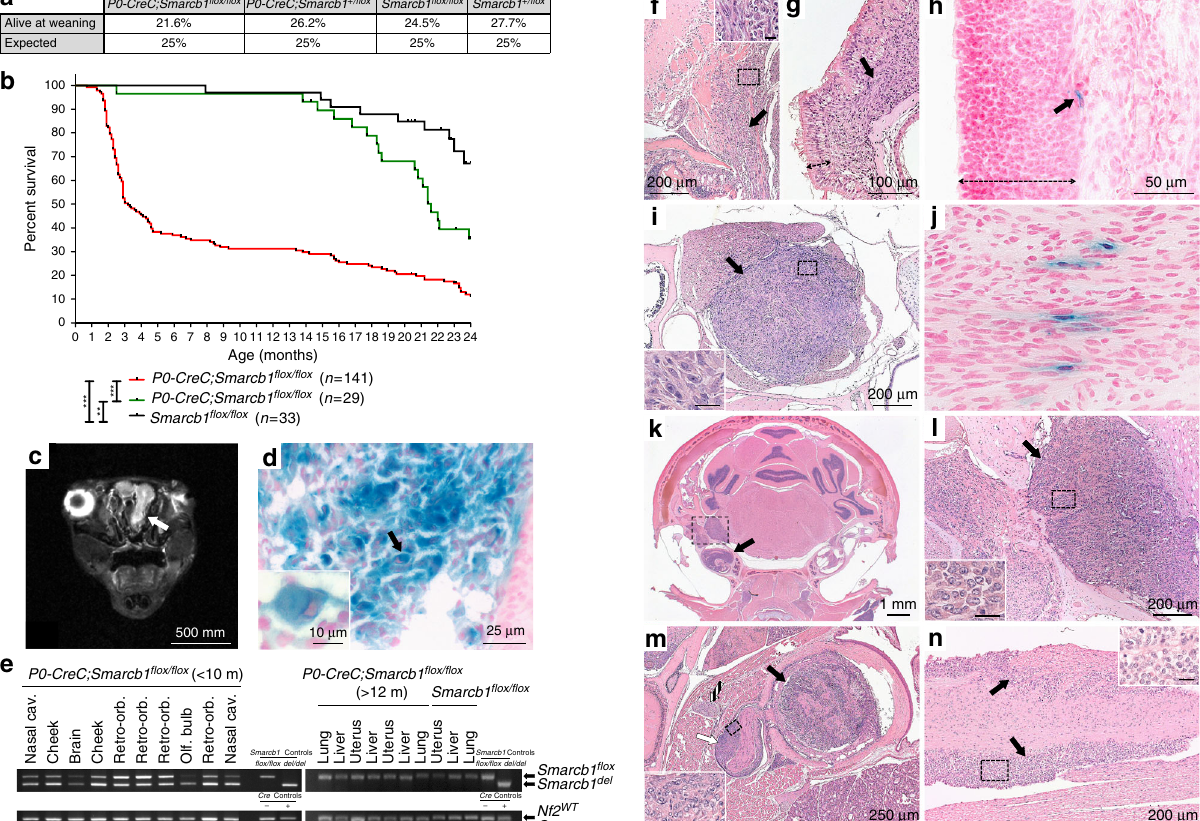
Fig. 1 P0-CreC;Smarcb1 fl ox/ fl ox mice develop RTs in NC-derived tissues. a Genotype distribution of mice at 3 weeks of age ( n = 282) born from crossings of P0-CreC;Smarcb1 fl ox/ + and Smarcb1 fl ox/ fl ox mice. b Kaplan – Meier curve representing the percent survival of P0-CreC;Smarcb1 fl ox/ fl ox ( n = 141, median survival = 3.2 months), P0-CreC;Smarcb1 fl ox/ + ( n = 29, median survival = 21.6 months) and Smarcb1 fl ox/ fl ox ( n = 33, median survival > 24 months) mice versus age in months. c T2-weighted MR image identifying a tumor mass in the nasal cavities of a P0-CreC;Smarcb1 fl ox/ fl ox mouse ( arrow ). d X-gal staining of a tumor from P0-CreC;Smarcb1 fl ox/ fl ox ; ACZL mice demonstrating activation of the beta-galactosidase reporter gene ACZL ( blue staining) thus attesting for Smarcb1 deletion throughout the tumor and in rhabdoid cells ( arrow and inset ). e Smarcb1 del allele is detected in all the tumors from young P0-CreC; Smarcb1 fl ox/ fl ox mice ( < 10 months of age). Long-term P0-CreC;Smarcb1 fl ox/ fl ox survivor mice (Supplementary Fig. 2c) develop liver, lung, and uterus tumors, with no deletion of Smarcb1 similar to control littermates ( Smarcb1 fl ox/ fl ox ). These tumors are part of the normal tumor spectrum of aging FVB/N mice 24 . f , g P0-CreC;Smarcb1 fl ox/ fl ox mice develop tumors along the olfactory nerve ( arrow ), close to the olfactory bulb ( f ) or in the nasal cavity below the olfactory epithelium ( double arrow , g ). h X-gal staining of the nasal cavity of a P0-CreC;AZCL mouse showing speci fi c Cre recombinase expression in SCs of the olfactory nerve ( arrow ) below the olfactory epithelium layer ( double arrow ). i Tumor of the trigeminal nerve (transversal section). j X-gal staining of the trigeminal nerve of a P0-CreC;AZCL mouse showing speci fi c Cre recombinase expression in SCs (arrows). k Tumor of the vestibulocochlear nerve ( dashed square ) invading the cochlea ( arrow ). Note that the contralateral side is not affected. l Detail of the vestibulocochlear nerve tumor shown in k . m Tumors in the eye ( black arrow ), optic nerve ( white arrow ), and oculomotor nerve ( striped arrow ) of a P0-CreC;Smarcb1 fl ox/ fl ox mouse. n Tumors in the spinal nerve roots ( arrows , longitudinal section). Insets in f , i , l , m and n represent a higher magni fi cation of the dashed square area ( insets scale bar is 20 µ m). **( P < 0.01) and ***( P < 0.001); log-rank (Mantel – Cox) with 62.5% (15/24) of the mice displaying multiple tumors at dissection. In all mice presenting with a head tilt and/or spinning and/or invasion of the inner ear were found (Fig. 1k, l). Use of the similarly to P0-CreC , but in a larger number of cells 25 , resulted